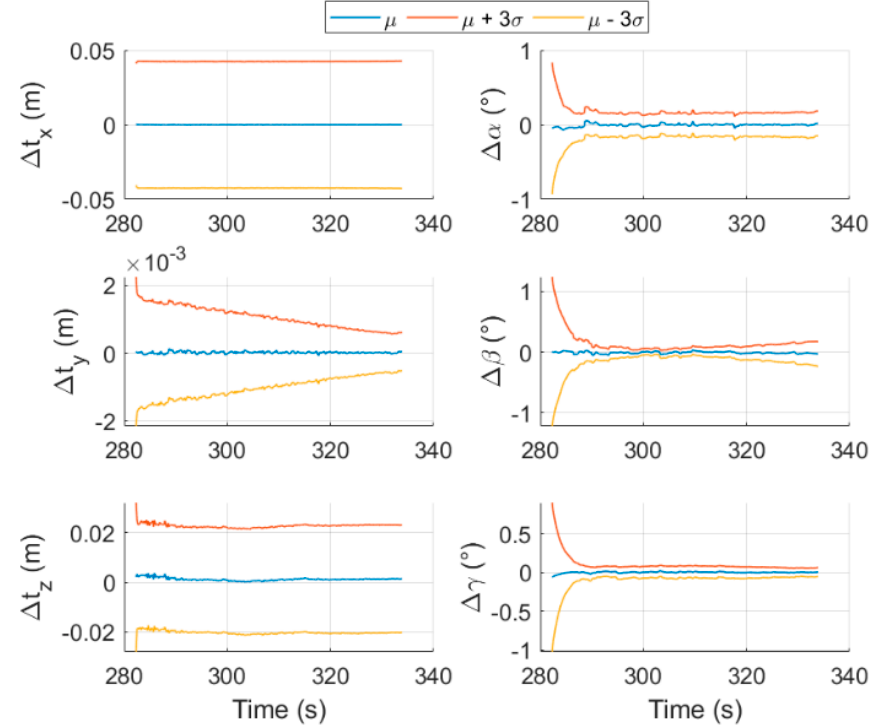
Figure 23. Temporal evolution of the mean of the errors on the pose parameters, with representation of the 3 σ intervals, for test case E-I.